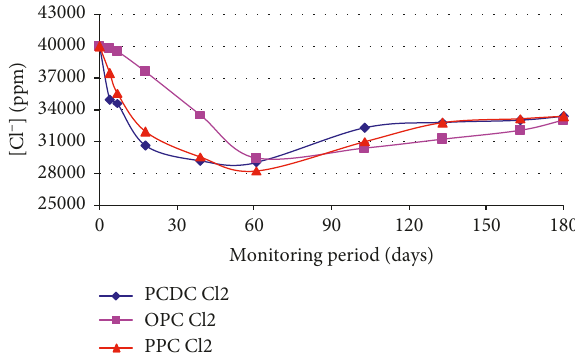
Figure 4: SO 42 analyses in chloride-simulated solution 2. −